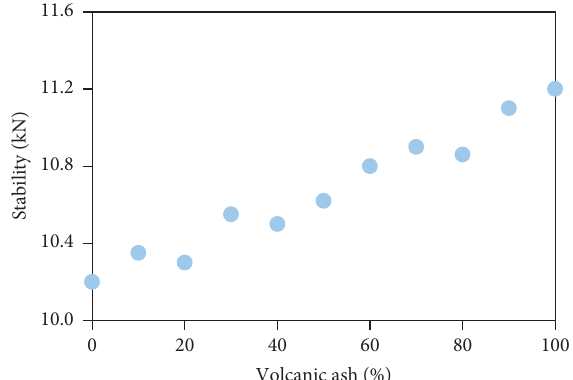
Figure 7: Impact of VA content on Marshall stability of HMA.